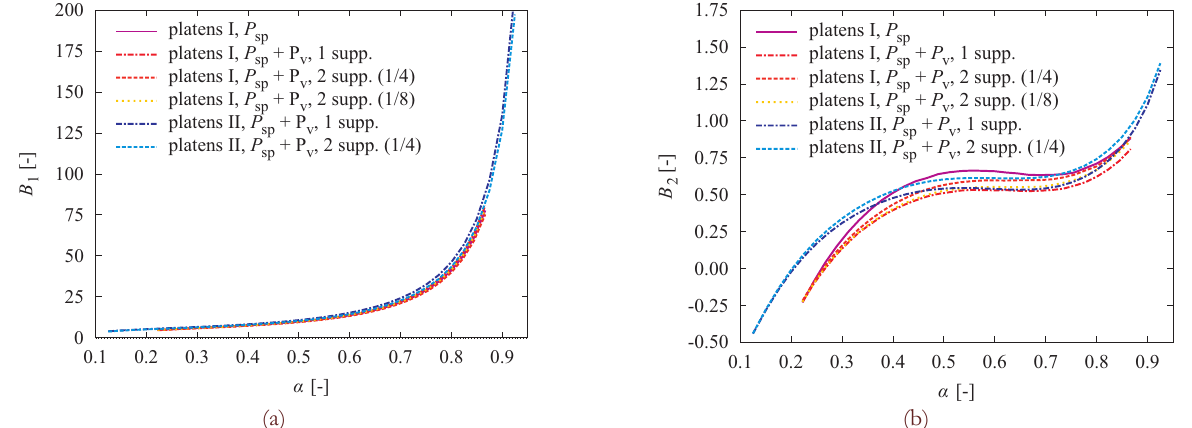
Figure 5: Geometry factors B 1 and B 2 as functions of the relative crack length  for various considered boundary conditions.